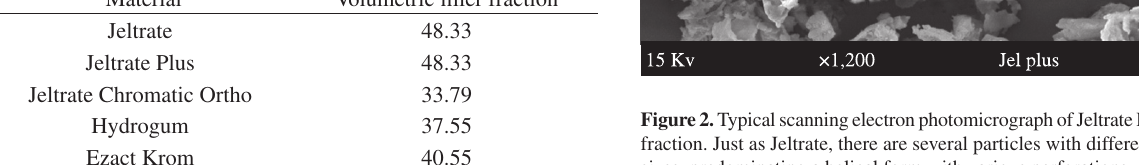
Table 2. Mean values for volumetric filler fraction of alginates (%). Material